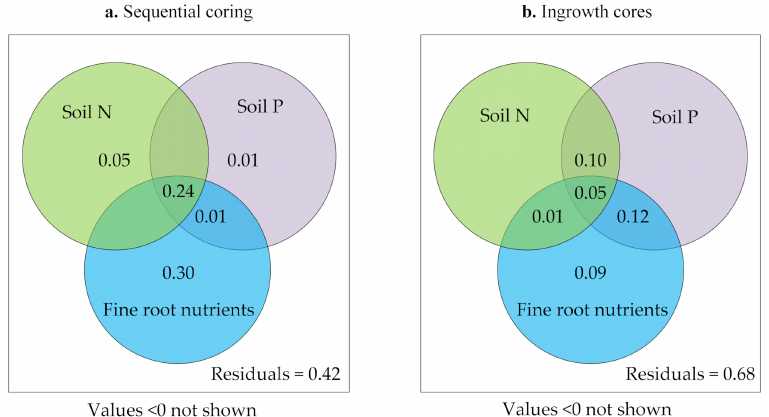
Figure 5. Venn diagram showing the variations in fine root turnover parameters contributed by soil N and P and fine root nutrients. Fine root turnover parameters included turnover rate, production, biomass, necromass, and biomass/necromass ratios; Soil N included total and available nitrogen concentrations; Soil P included total and available phosphorus concentrations; Fine root nutrients included fine root C and N